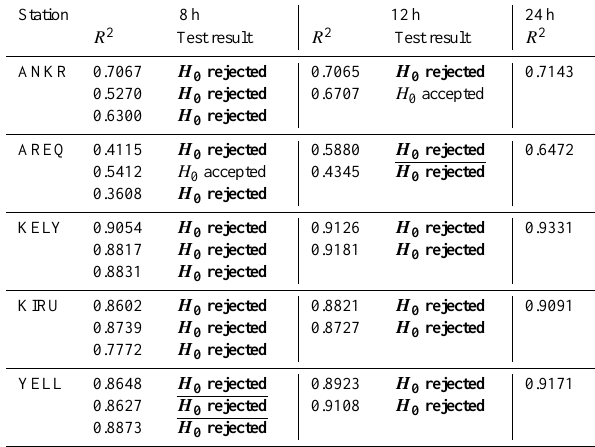
Table 4. Hypothesis testing results for ellipsoidal height: rejections indicated in bold-faced letters are related to an F test; rejections indicated in underlined bold-faced letters are from Student’s t test; the stations with R 2 values smaller than 0.90 are not used in the